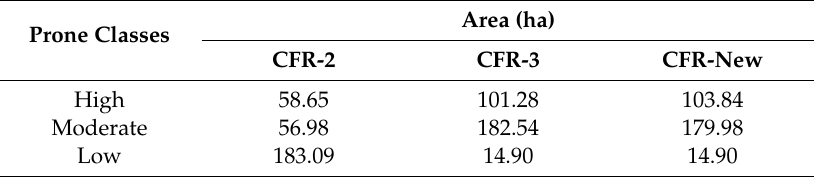
Table 5. Flood-prone area of CFR-2, CFR-3, and CFR-new.